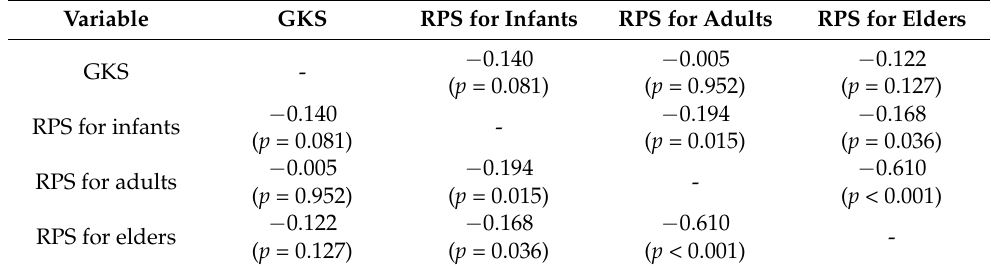
Table 3. Correlation between synthetic scores, i.e., general knowledge score (GKS) and risk perception score (RPS), calculated for infants, adults and the elderly. Spearman’s correlation test (rho) with their respective p